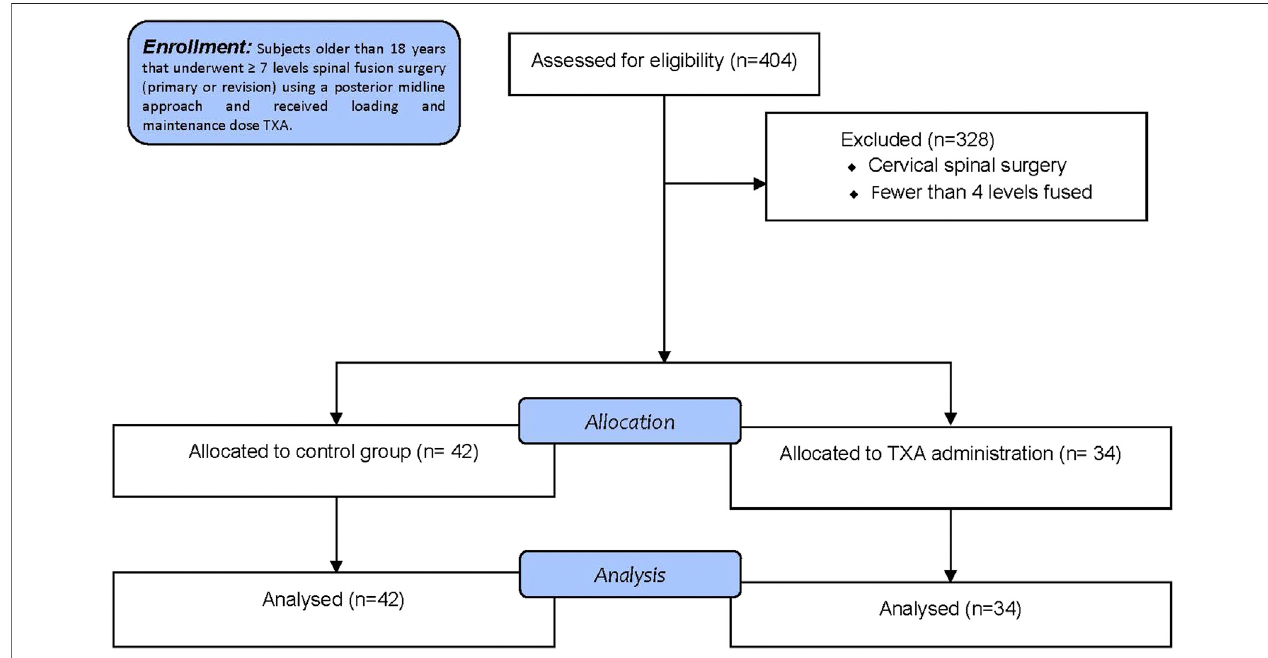
FIGURE 1 | Retrospective analysis consort fl ow diagram. N, number; TXA, tranexamic